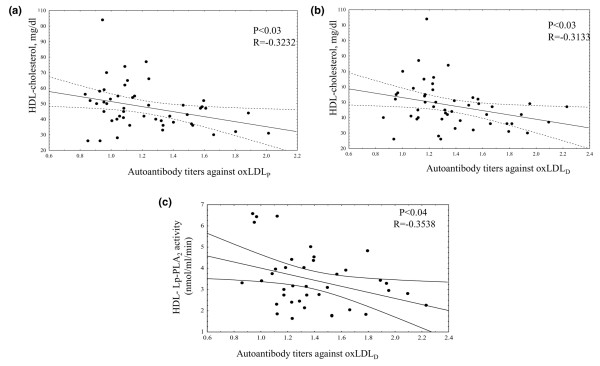
Correlation between serum levels of high-density lipoprotein-cholesterol and autoantibody titers against oxidized low-density lipoprotein. Correlation between serum levels of high-density lipoprotein (HDL)-cholesterol and autoantibody titers against (a) oxidized low-density lipoprotein in the propagation phase (oxLDLP) and (b) oxidized low-density lipoprotein in the decomposition phase (oxLDLD) in early rheumatoid arthritis patients at baseline. (c) Correlation between HDL-associated lipoprotein-associated phospholipase A2 (HDL-Lp-PLA2) activity and autoantibody titers against oxLDLD in early rheumatoid arthritis patients at baseline.